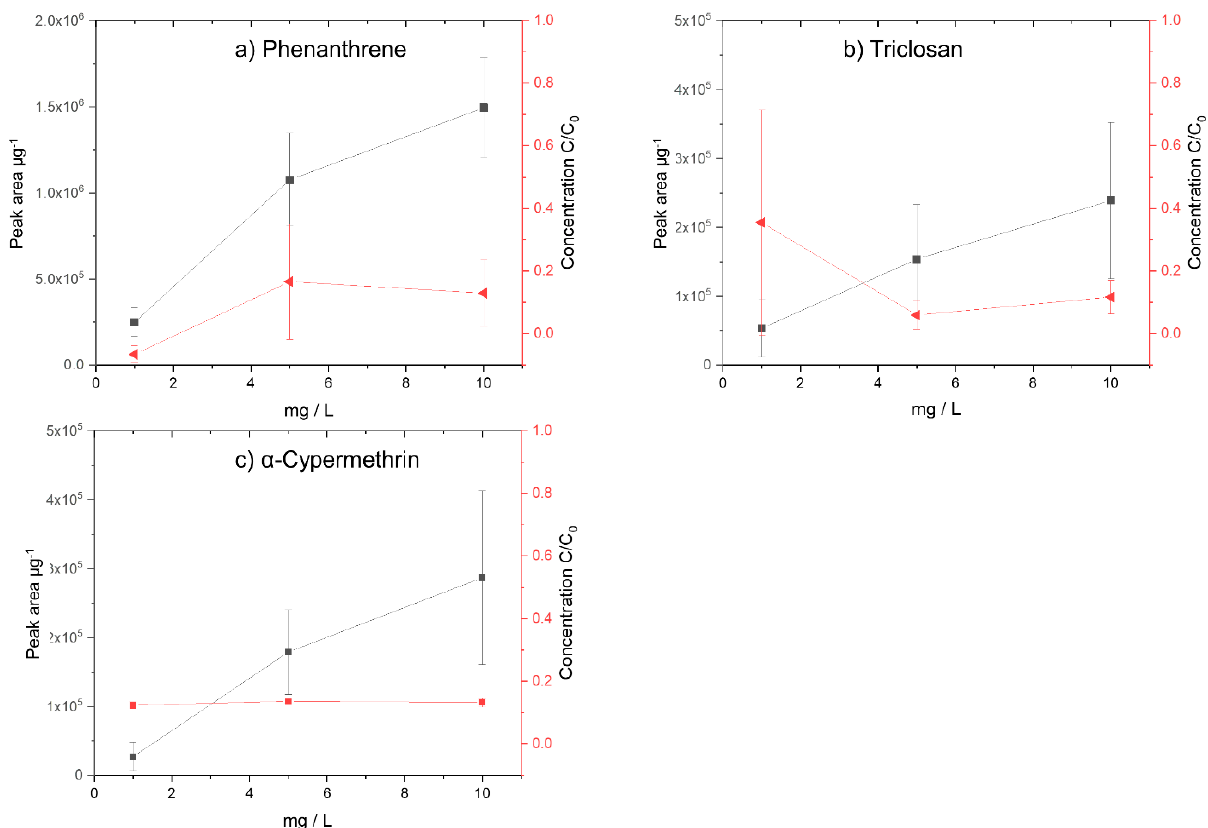
Figure 5. Analysis of initial concentration of 1 mg/L, 5 mg/L, and 10 mg/L in the aqueous phases via TD-GC/MS (C/C 0 ) and the particle phases via TD-Pyr-GC/MS (peak area µg − 1 ) for the TOrCs ( a ) phenanthrene, ( b ) triclosan, and ( c ) α -cypermethrin. On the left y -axis (black, square), the sorption on the particles (peak area µg − 1 ) is shown; on the right y -axis (red, triangle) the concentration in the aqueous phase (C/C 0 ) is presented.